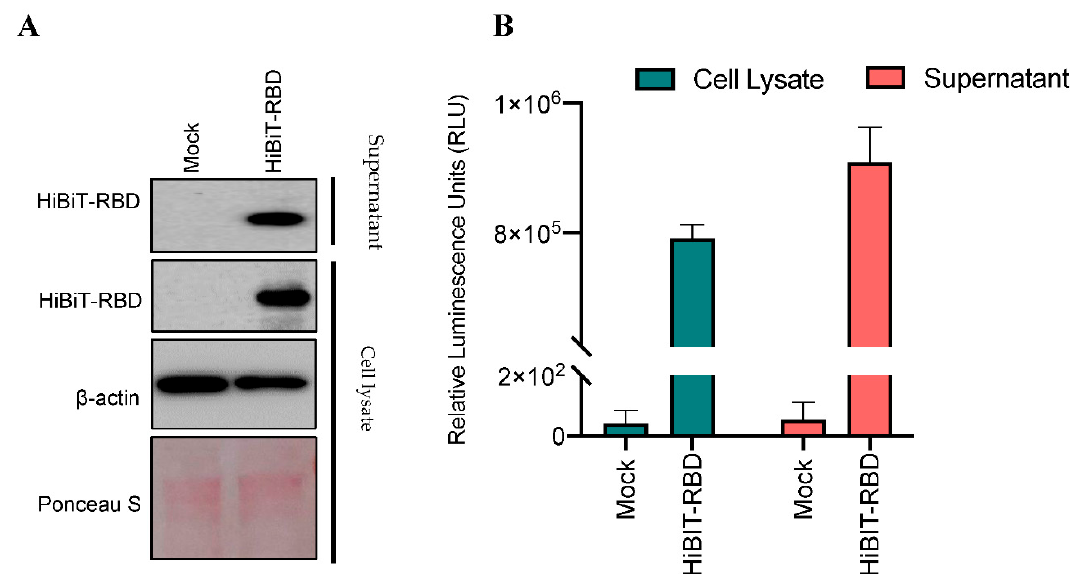
Figure 1. Illustrations of the interactions involving SARS-CoV-2 RBD. ( A ) Interactions between the RBD portion of SARS- CoV-2 and the ACE2 receptor on the host cell can be impaired via neutralizing antibodies. ( B ) Interactions between HiBiT- RBD and LgBiT lead to the generation of bioluminescence signal after substrate digestion.